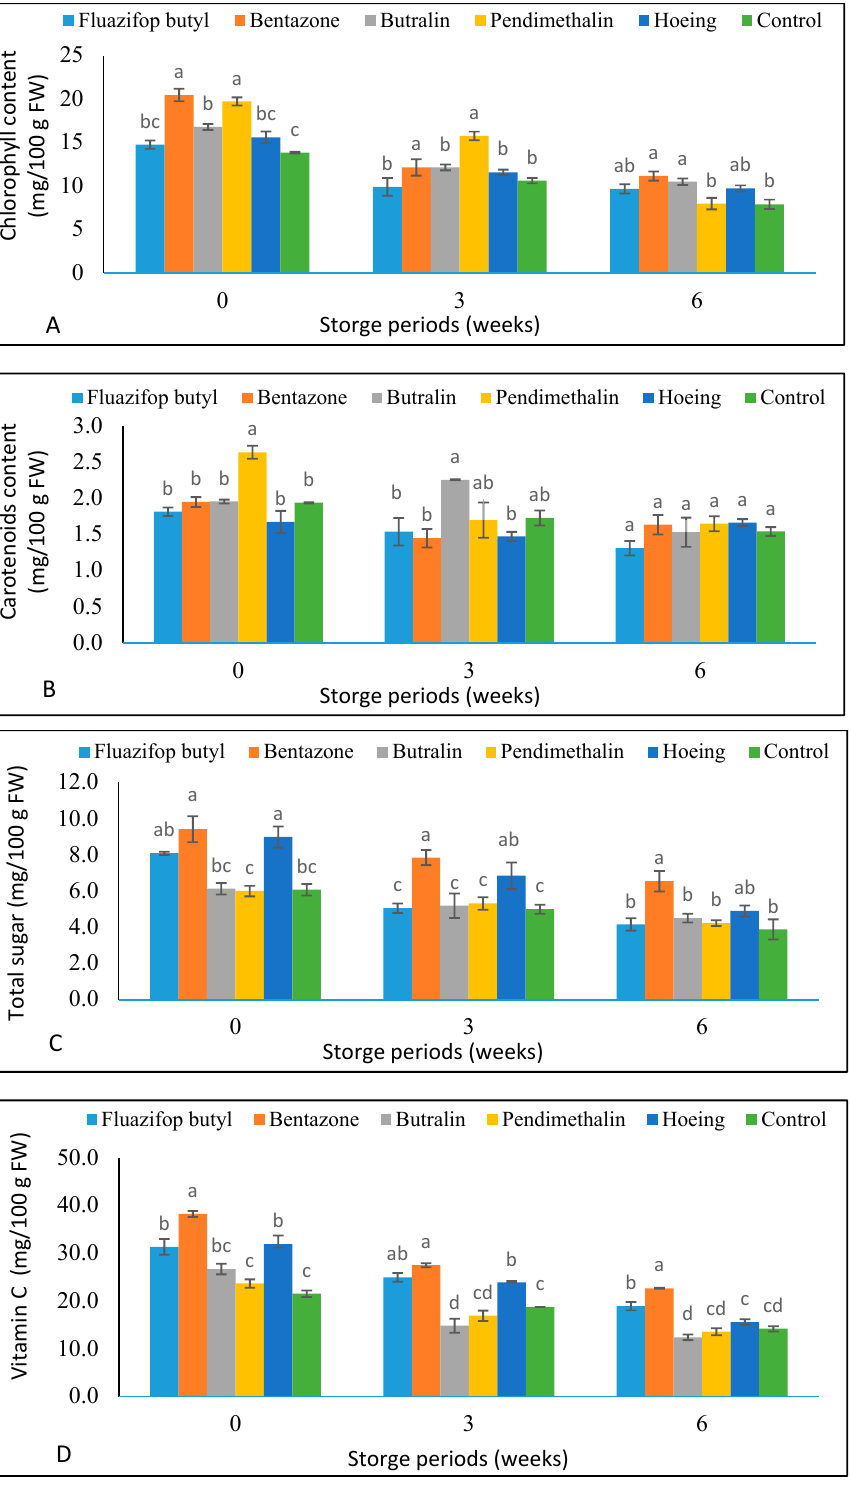
Figure 6. Effect of pre- and postemergence herbicides on chlorophyll content ( A ), carotenoid ( B ), total sugar ( C ), and vitamin C ( D ). Different letters indicate significant differences between treatments (Duncan test at p < 0.05); vertical bars indicate standard error.